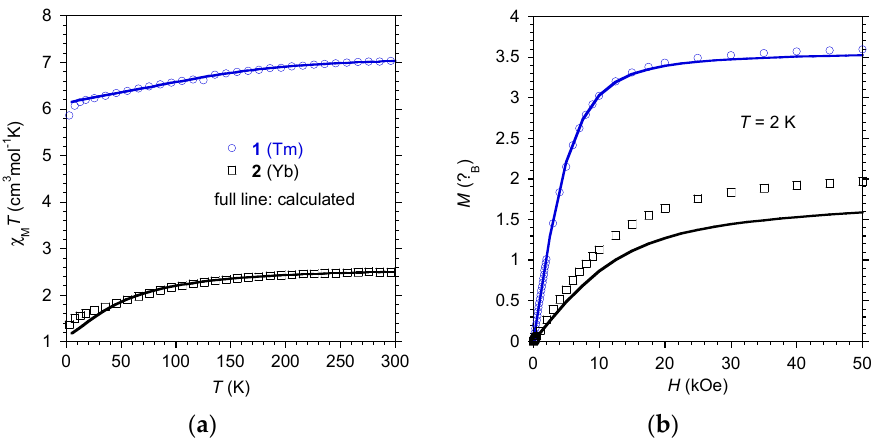
Figure 2. ( a ) Temperature dependence of χ M T and ( b ) magnetization at 2 K for the complexes 1 (in blue) and 2 (in black). Full lines correspond to the ab initio calculated behaviors.